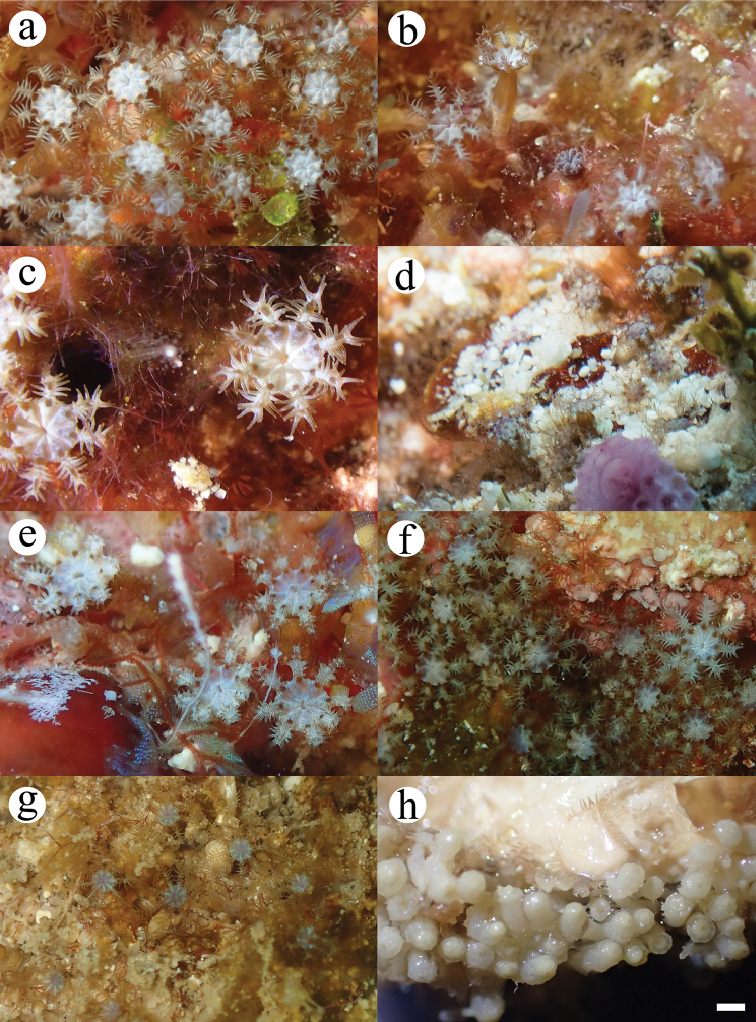
In situ photographs of examined Hana specimens from Okinawa, aHanahanagasa, holotype, OKA170711-15 and bHanahanagasa, paratype, OKA170711-06; Palau cHanahanataba holotype, ROR171225-01 and dHanahanataba, paratype, ROR171226-03; Dongsha eHanahanataba, paratype, DSX180320-1-01 and fHanahanataba, paratype, DSX180324-3-15 g specimen BKI180320-2-10, an arulid photographed in Tunku Abdul Rahman Park, Sabah, Malaysia hHanahanagasa, holotype, OKA170711-15, colony preserved in ethanol. Scale bar: 1 mm.